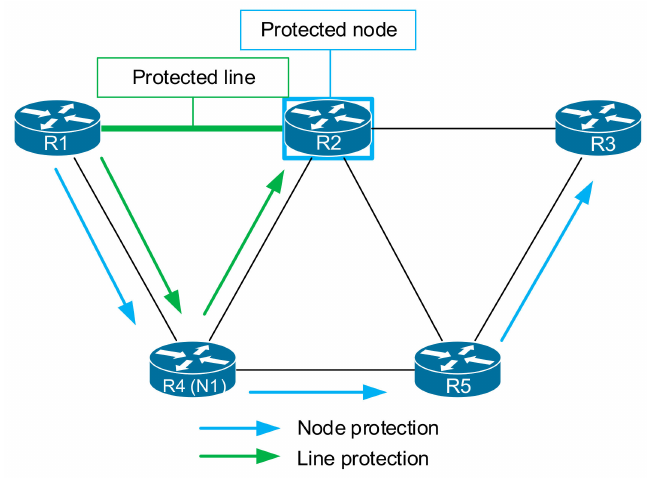
Figure 2. Line and node